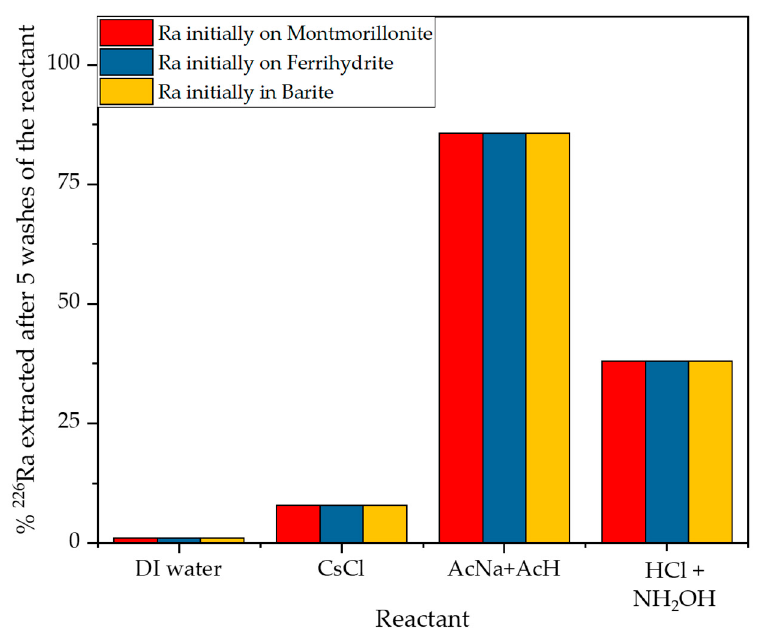
Figure 3. Percentage of 226 Ra extracted by five washes of one of the reactants depending on the mineral the 226 Ra is initially bound to.